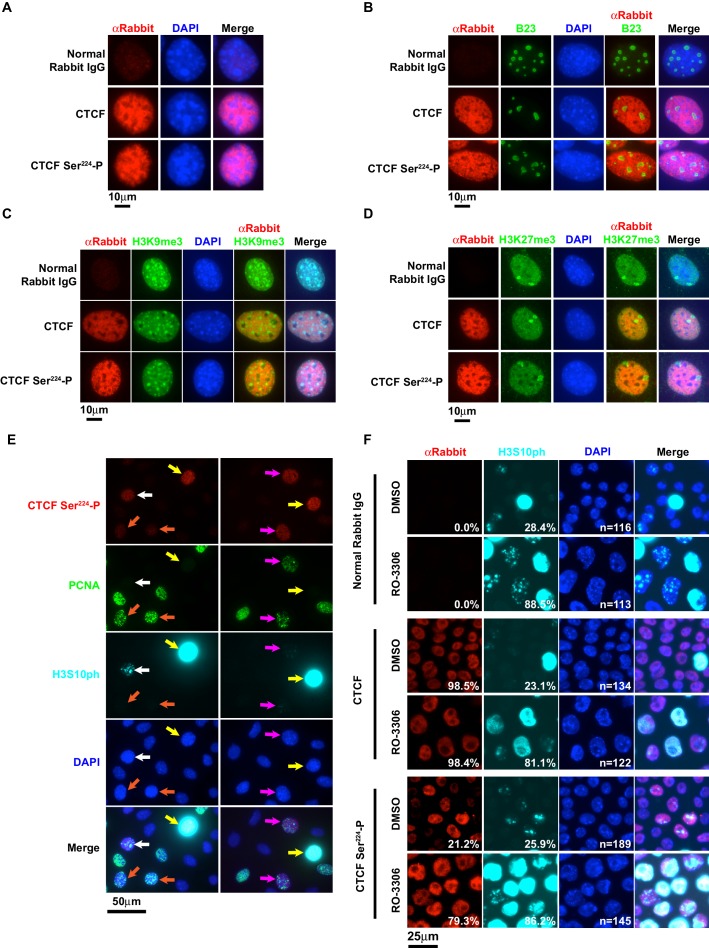
CTCF Ser224-P accumulates in G2 and has a subnuclear distribution comparable to total CTCF.(A–D), Immunofluorescence performed on immortalized MEFs using the indicated antibodies. Nuclei counterstained with DAPI. Bar, 10 μm. (E) Immunofluorescence performed on asynchronous MEFs with the indicated antibodies. Nuclei counterstained with DAPI. Bar, 50 μm. White arrows (PCNA negative, speckled H3S10ph), early G2. Yellow arrows (PCNA negative, pronounced H3S10ph), late G2. Orange arrows (Speckled PCNA, no H3S10ph), S. Magenta arrows (Speckled PCNA, faint speckled H3S10ph), late S/early G2. (F) Immunofluorescence performed on TST-1 mESCs with the indicated antibodies. Cells were treated 20 hr with 10 μM RO-3306 or DMSO alone control. Bar, 25 μm.